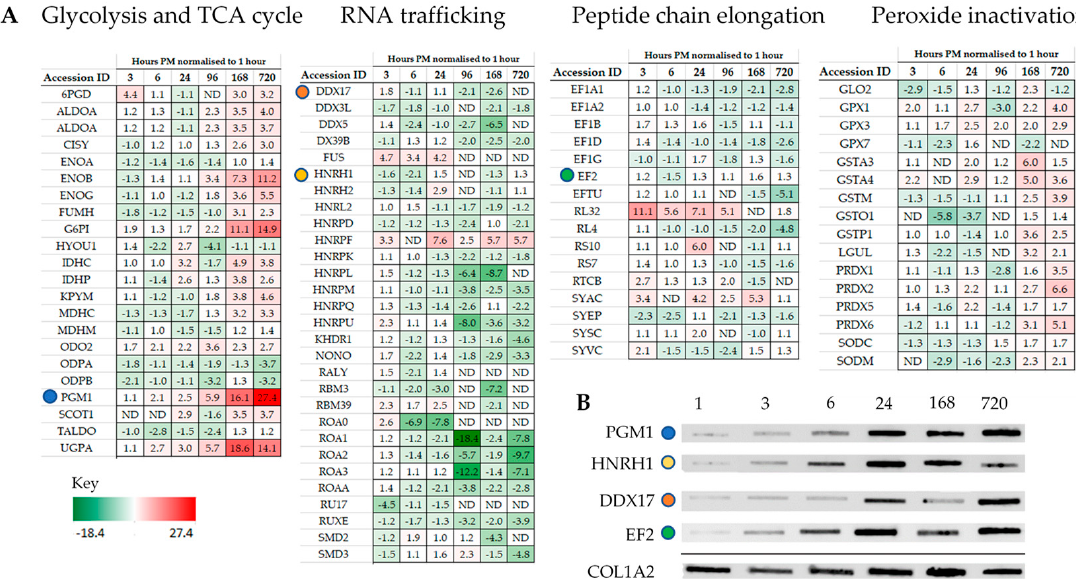
Figure 3. Representation from major pathways can be followed through PM time with some proteins increasing in abundance as far as 720 h PM. ( A ) Proteins representative of glycolysis and TCA cycle pathway, RNA trafficking, and elongation of the polypeptide change. ( B ) Protein abundance by antibody detection can be compared for the same mice against the sampling control protein Col1A2. Coloured circles highlight proteins assayed across both mass-spectrometry and antibody detected datasets.